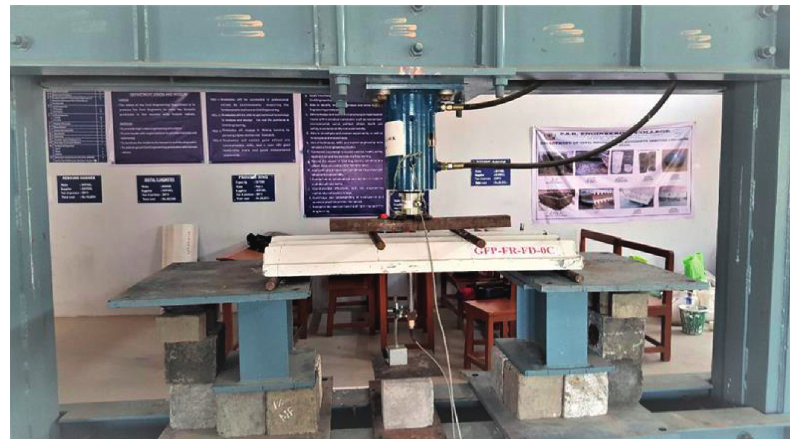
Figure 9: Flexural test on the GF folded panel.